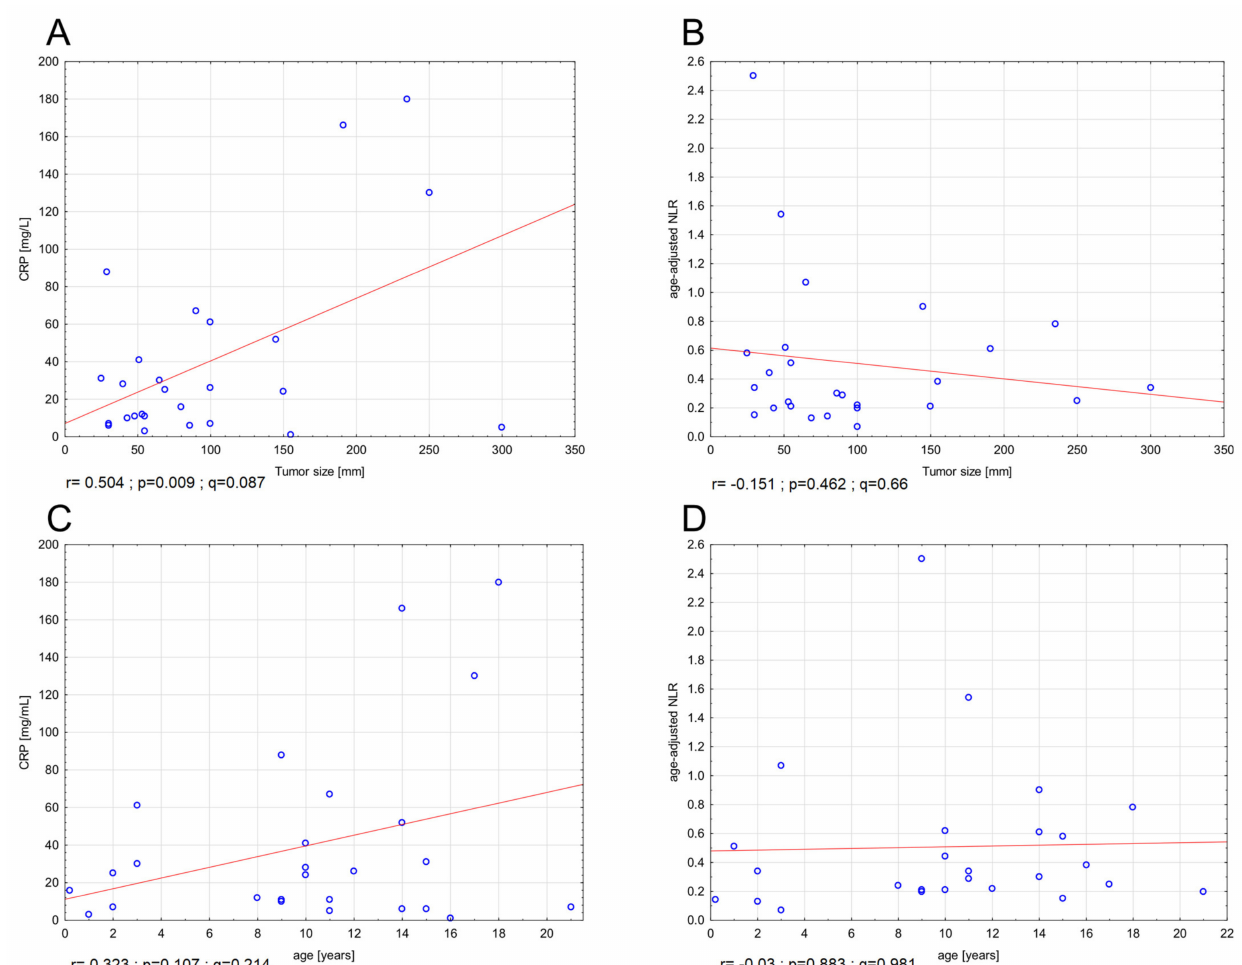
Figure 7. Correlations between CRP and tumor size ( A ); NLR and tumor size ( B ); CRP and age ( C ); NLR and age ( D ). Abbreviations: CRP—C-reactive protein, NLR—neutrophil-to-lymphocyte